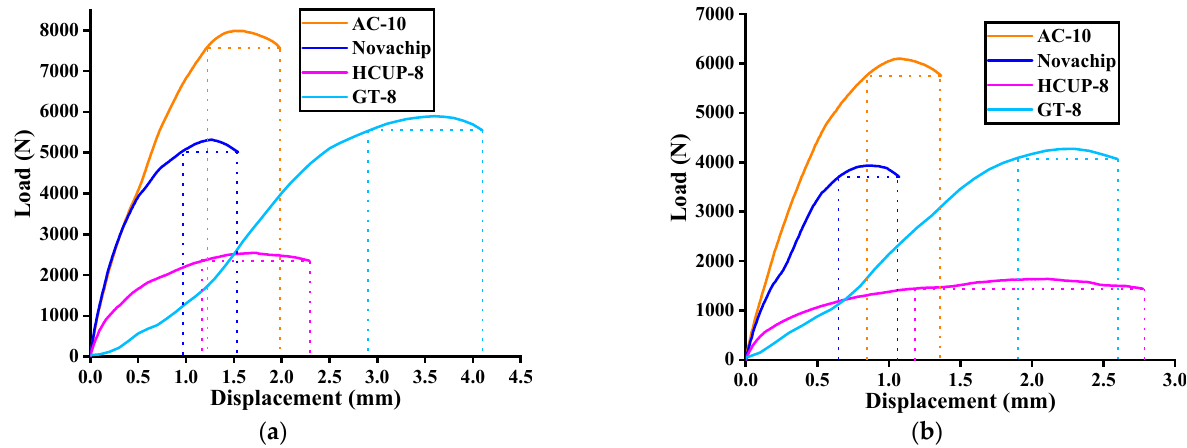
Figure 8. Load–displacement curve of semicircle bending test: ( a ) the notch depth is 15 mm; ( b ) the notch depth is 25 mm.